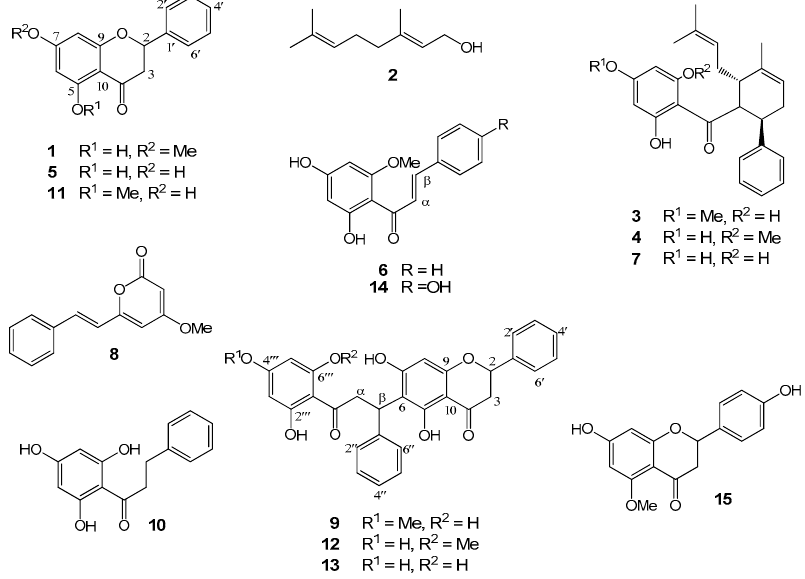
Figure 1. Chemical structures of Compounds 1 – 15 isolated from Boesenbergia rotunda .